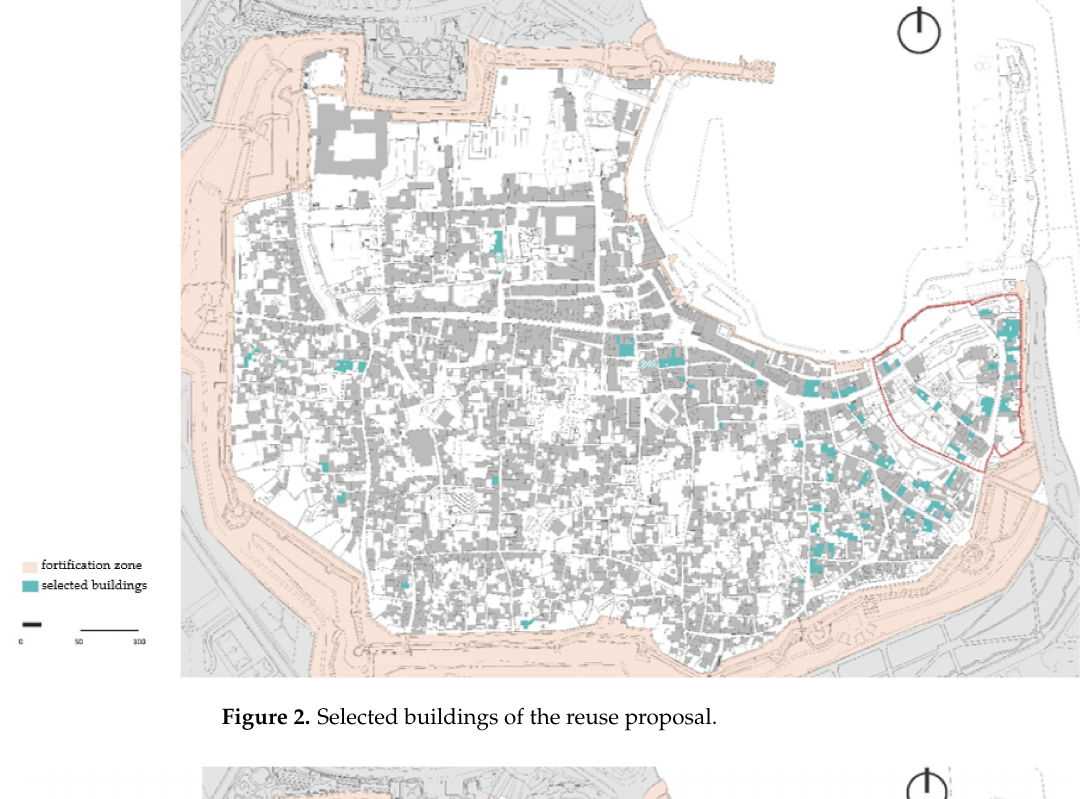
Figure 2. Selected buildings of the reuse proposal.